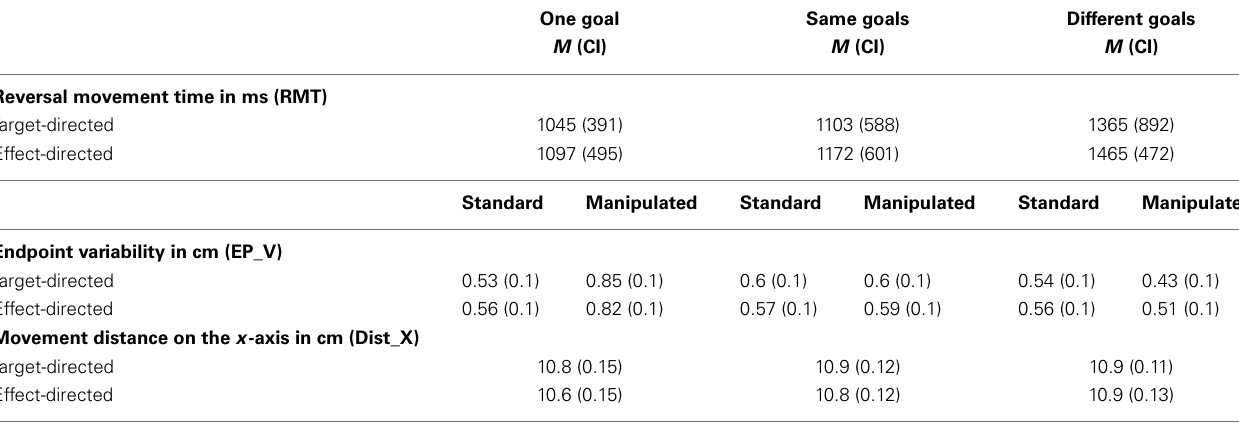
Table 1 | Experiment 1: variables describing temporal and spatial